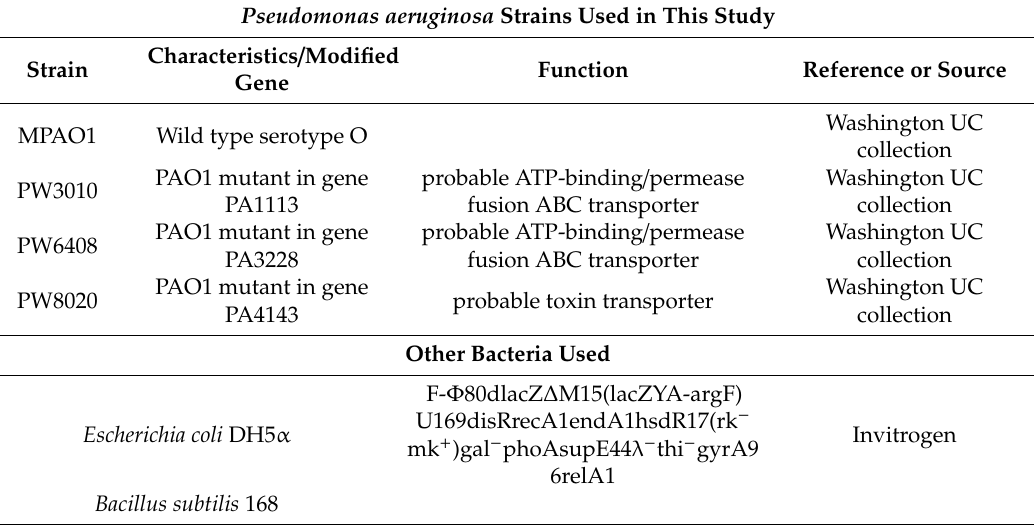
Table 3. Pseudomonas aeruginosa and other bacteria strains used in this study. Pseudomonas aeruginosa Strains Used in This Study Characteristics / Modified Strain Function Reference or Gene